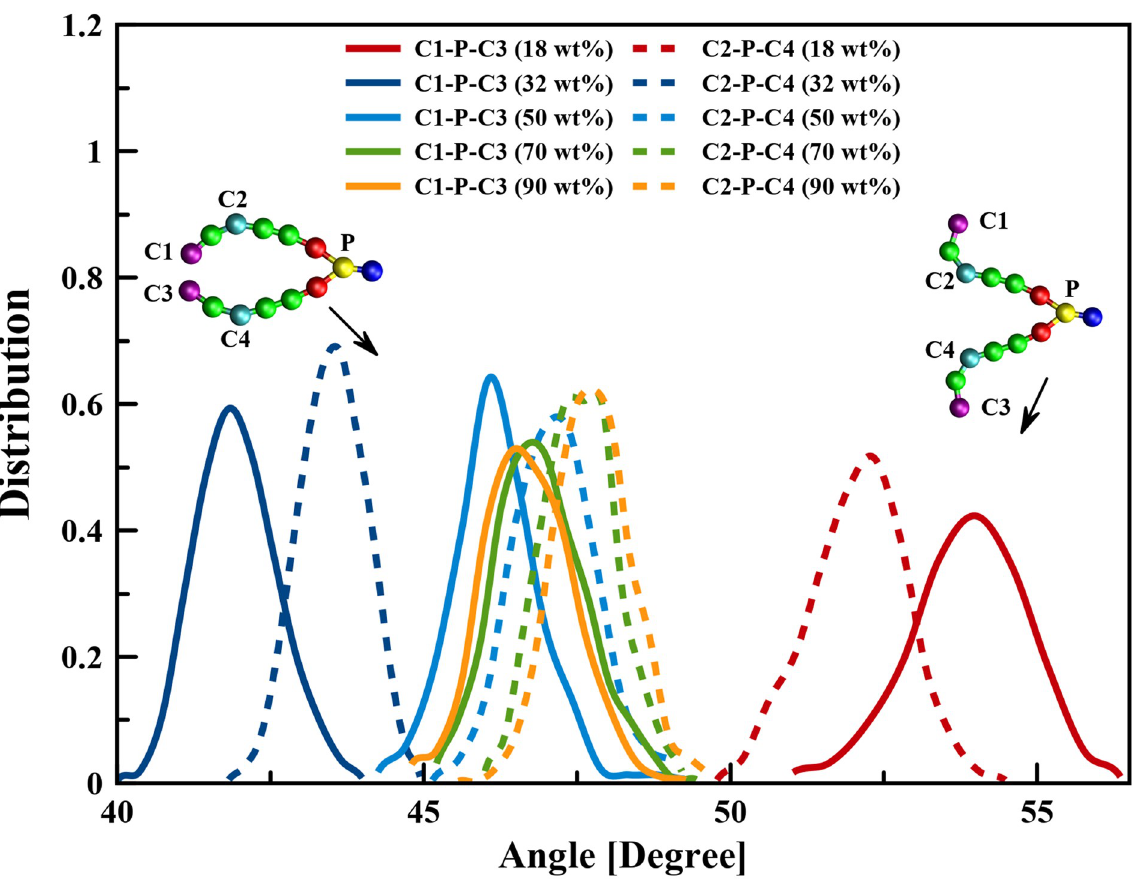
Fig 11. The distribution functions of the two order parameters representing the angles ^ C 1 (cid:0) P (cid:0) C 3 and ^ C 2 (cid:0) P (cid:0) C 4 . The molecular shape of the DOPE at 18 wt% water content is different from the other water